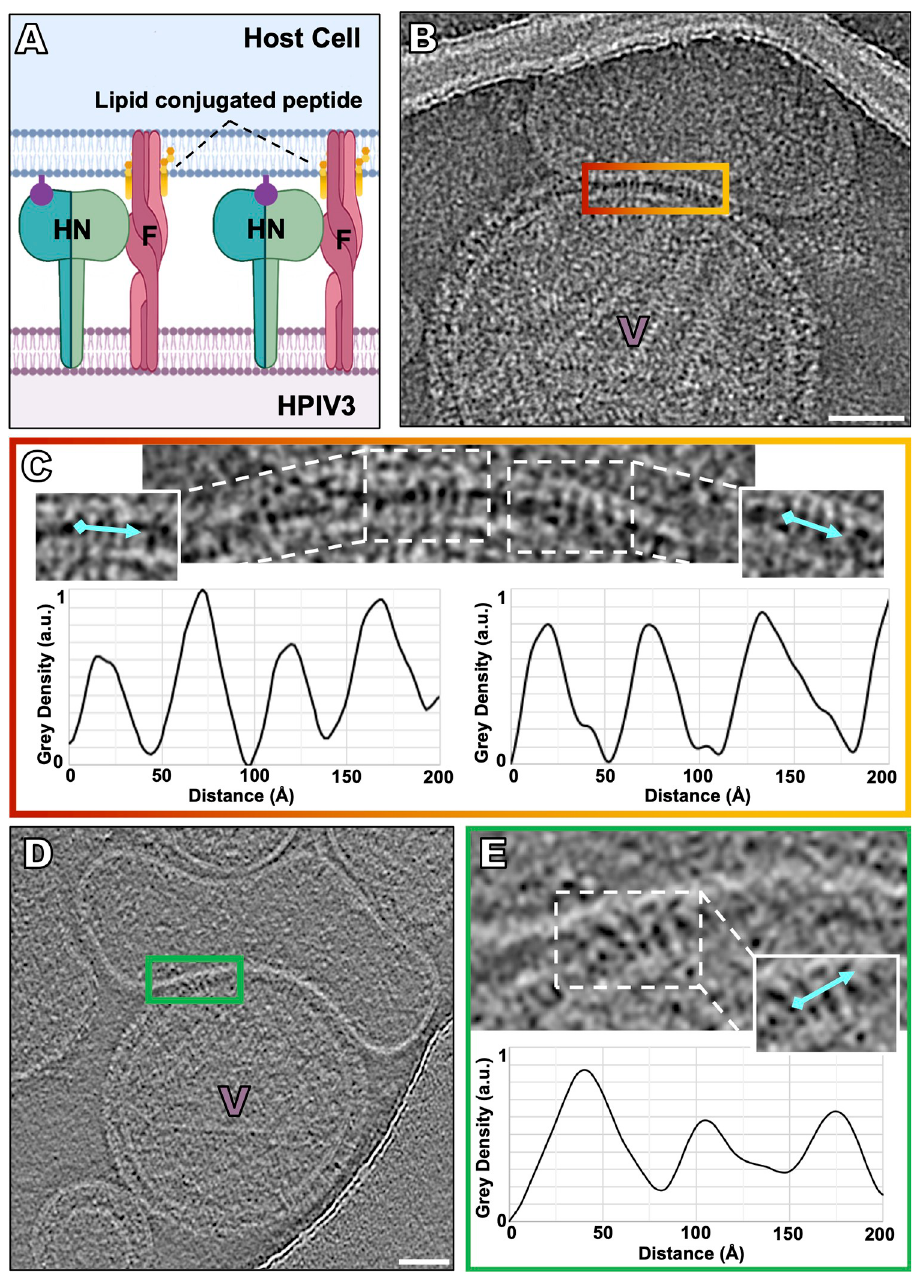
Fig 4. Capture of the transient intermediate state of F with lipid-conjugated fusion inhibitory peptides. To capture the transient intermediate fusion state just after HN activates F, receptor-bearing target erythrocyte fragment membranes were exposed to virus on grids at 37˚C in the presence of lipid conjugated fusion inhibitory peptides (i . e ., VIKI-PEG 4 -chol), prior to vitrification. ( A ) Schematic of lipid-conjugated peptides inserting into the target cell membrane via their lipid tails and “locking” the extended F in its transient intermediate state, preventing refolding to the post-fusion conformation. ( B, D ) Contrast-inverted images where viral particles can be observed attached to target erythrocyte fragment membranes using ( B ) cryo-EM and ( D ) cryo-ET. ( C, E ) Enlarged region of interactions between the viral and target erythrocyte fragment membranes where elongated densities linking both membranes are visible. Insets include cyan lines where distance plot measurements were taken. (C,D,E, bottom) Density line plots revealing a repeating 20–35 Å -wide density. Scale bars: ( B, E ) 50